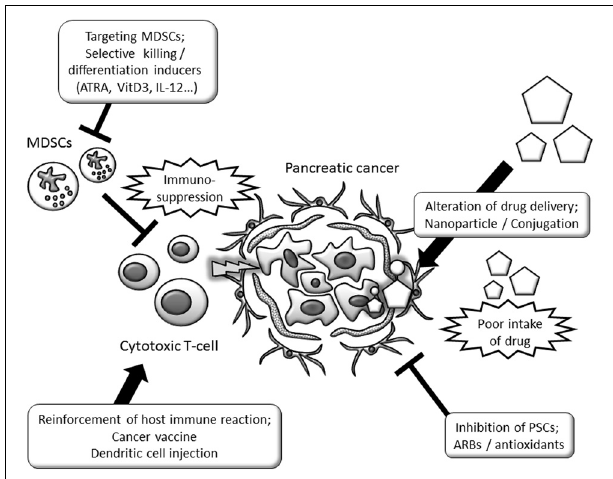
FIGURE 2 | Schematic view of therapy-resistance related tumor-stromal interaction and possibility as a tumor stroma-targeting therapy. Stroma-targeting strategies include the modification of drug delivery, inhibition of PSC functions and restoration of immune functions. ARB, angiotensin II type 1 receptor blocker; ATRA, all-trans retinoic acid; IL, interleukin; MDSCs, myeloid-derived suppressor cells; PSCs, Pancreatic stellate cells; Shh, sonic hedgehog; SPARC, Secreted protein acidic and rich in